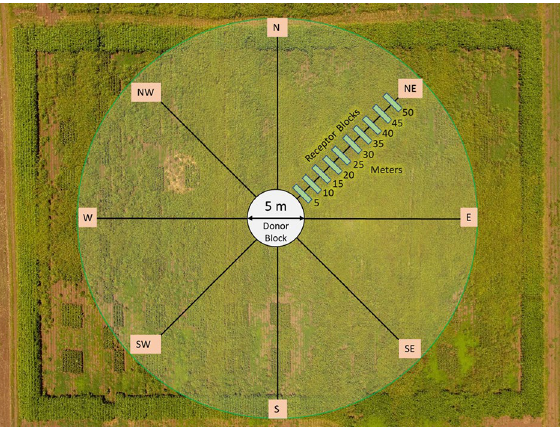
Figure 1. Aerial view of the experimental arrangement that was used to quantify pollen-mediated gene flow from ALS-inhibitor resistant (AR) to -susceptible (AS) johnsongrass at the Texas A&M University Research Farm near College Station, Texas. AR johnsongrass plants were transplanted in the pollen-donor block of 5 m diameter at the center of the field. The surrounding pollen-receptor area was divided into four cardinal (N, E, S, W) and four ordinal (NE, SE, SW, NW) directional blocks where naturally-existing AS johnsongrass plants were used as the pollen-recipients. AS panicles exhibiting flowering synchrony with AR plants were tagged at specific distances (5–50 m, at 5 m increments) along the eight directional arms. A tall-growing biomass sorghum border was established in the perimeter of the experimental site to prevent pollen inflow from outside